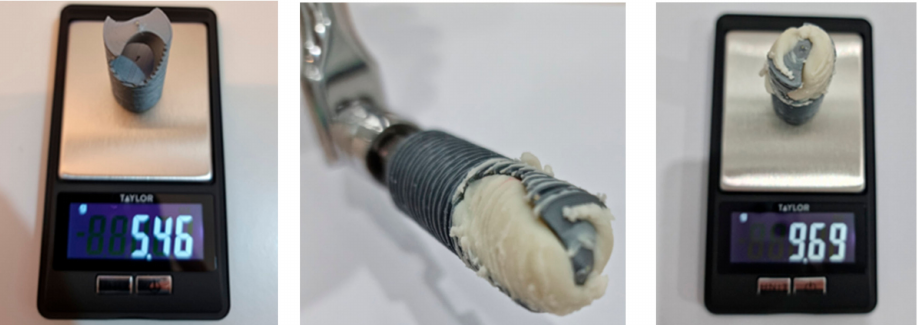
Figure 4. BKS device 3D printed and Taylor Precision Compact Digital scale before and after com- pacting Aluminum Phyllosilicates